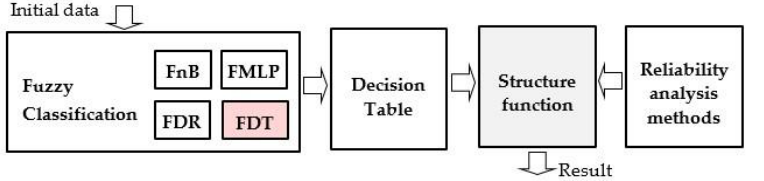
Figure 2. The structure of the methods of the risk and reliability analysis based on incomplete or uncertain initial data.